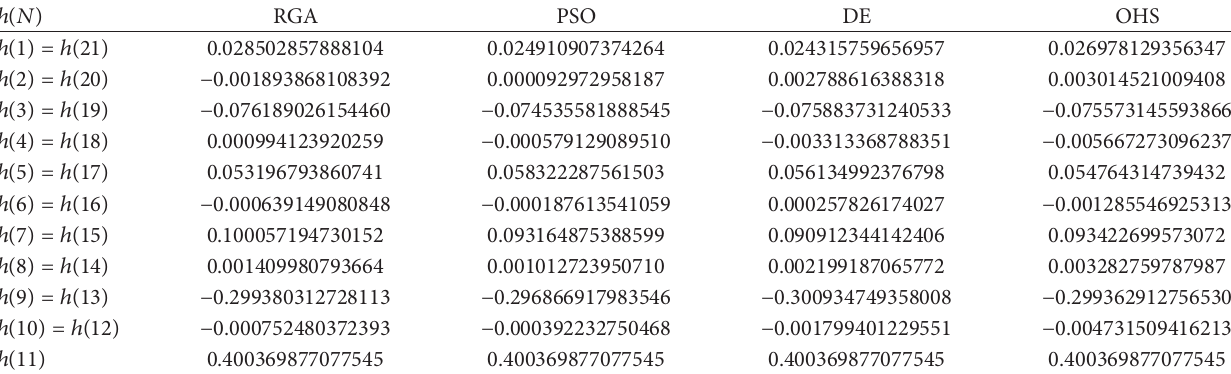
Table 4: Optimized coefficients of the FIR BP filter of order